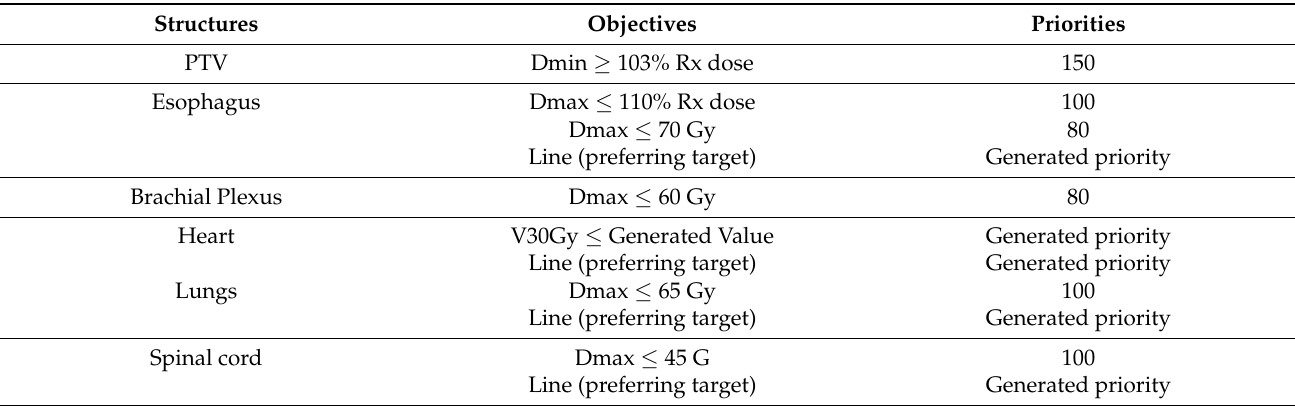
Table 2. Model Optimization and Priority Settings.